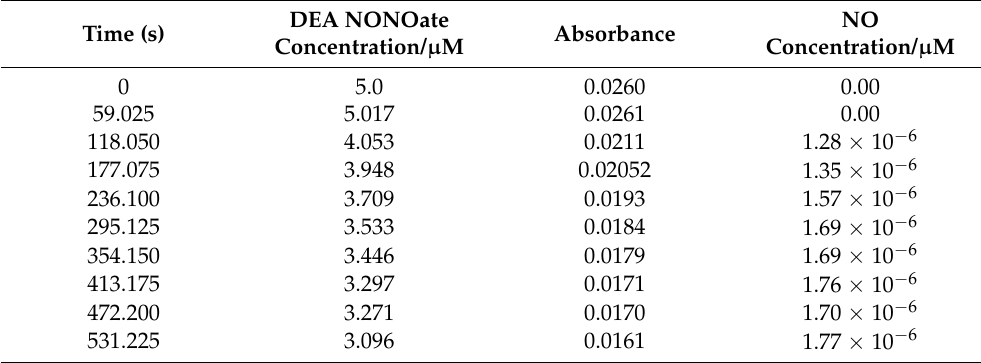
Table 2. Data relating NONOate concentration to that of NO obtained from time-dependent NONOate